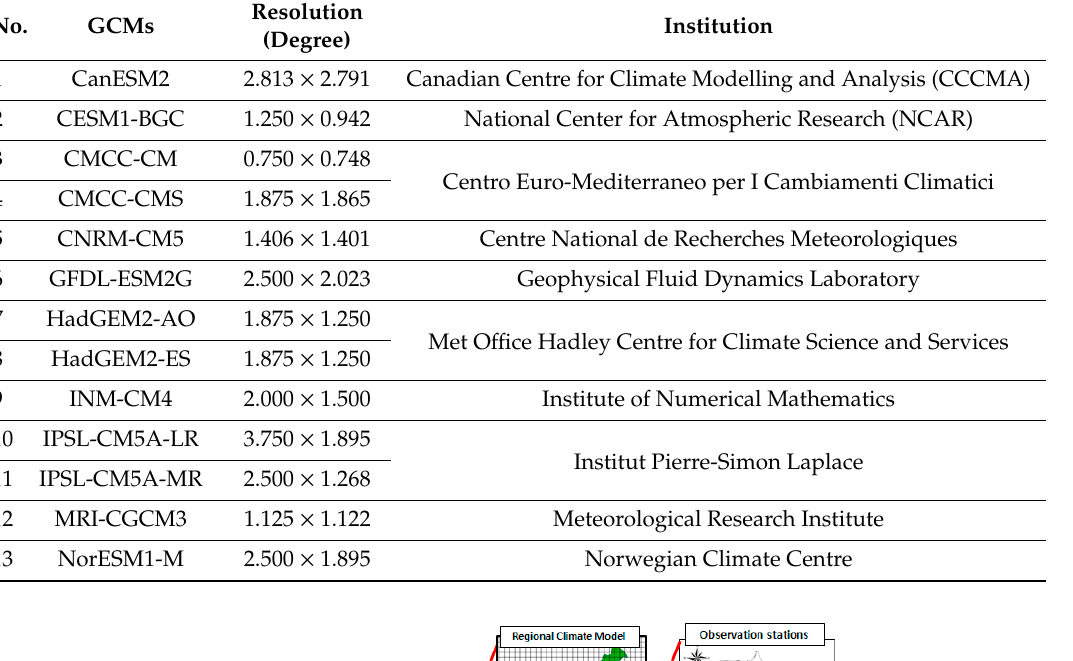
Table 1. Thirteen global climate models (GCMs) used for the study.